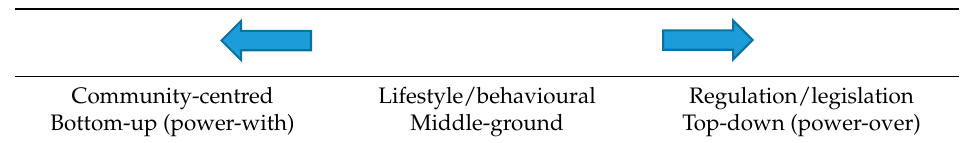
Table 1. Moving to the extremes to address obesity.